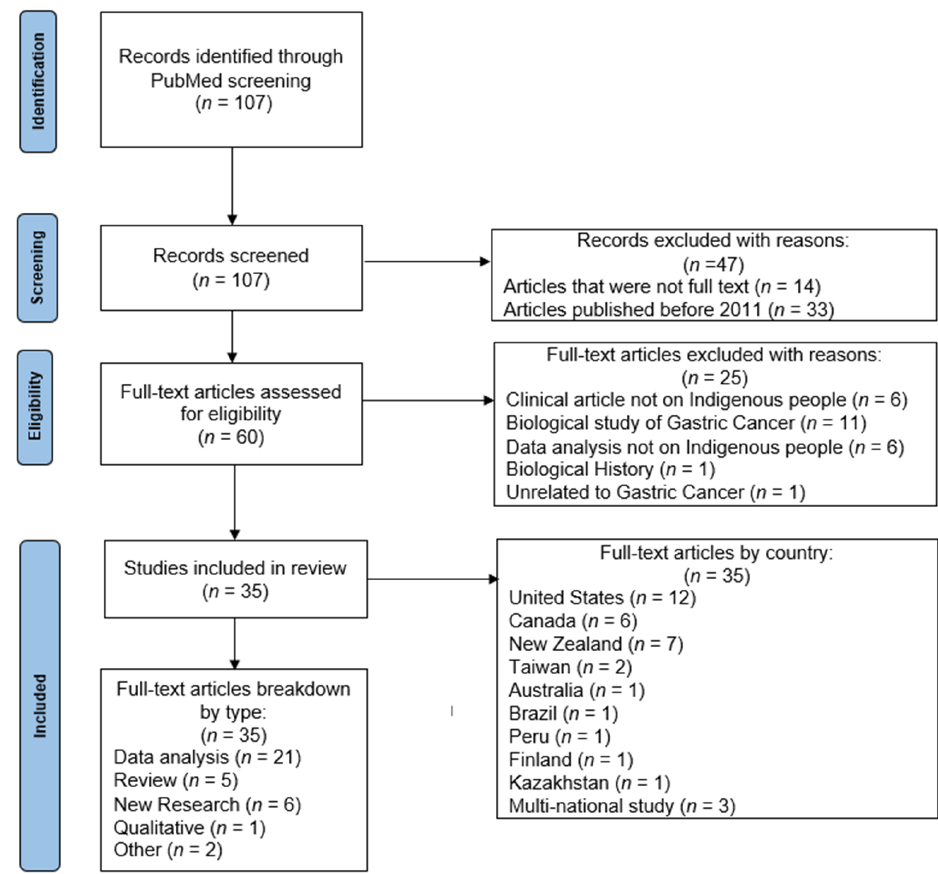
Figure 1. Systematic literature review, PubMed from 2011–2021.